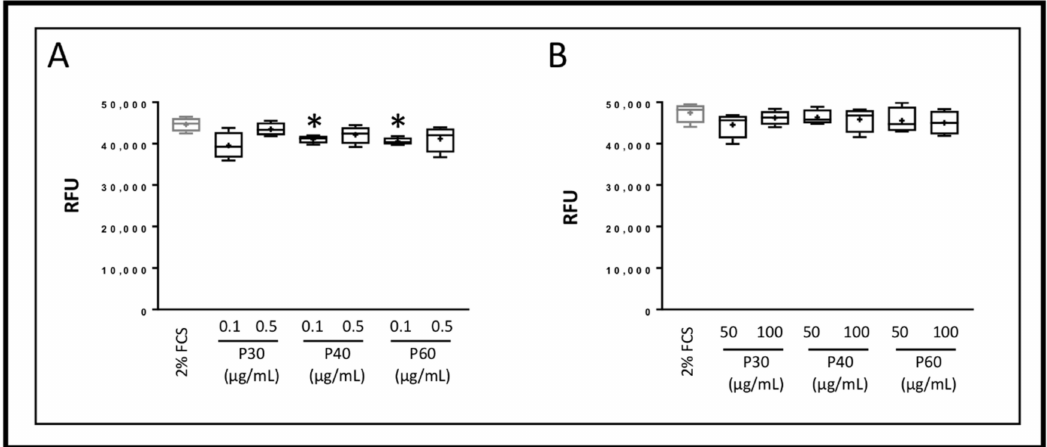
Figure 5. Effect of Promerim ® 30, 40 and 60 on the senescence of human articular chondrocytes. Human articular chondro- cytes at P2 and 80% confluency were treated in the presence of 2% FCS, with Promerim ® 30, 40 or 60 (P30, P40 or P60) at 0.1 and 0.5 µ g/mL ( A ), 50 and 100 µ g/mL ( B ) for 72 h in hypoxia. Controls with 2% FCS were performed (Ctrl) and the levels of β -galactosidase were measured 3 days post-treatment. Results are summarized in box plots ( n = 4) showing the mean (cross) and the median (line) of relative fluorescence units (RFU) corresponding to the levels of SA- β -galactosidase activity. Statistical analyses were performed using the Mann–Whitney test (* p < 0.05) and the control condition was used as the